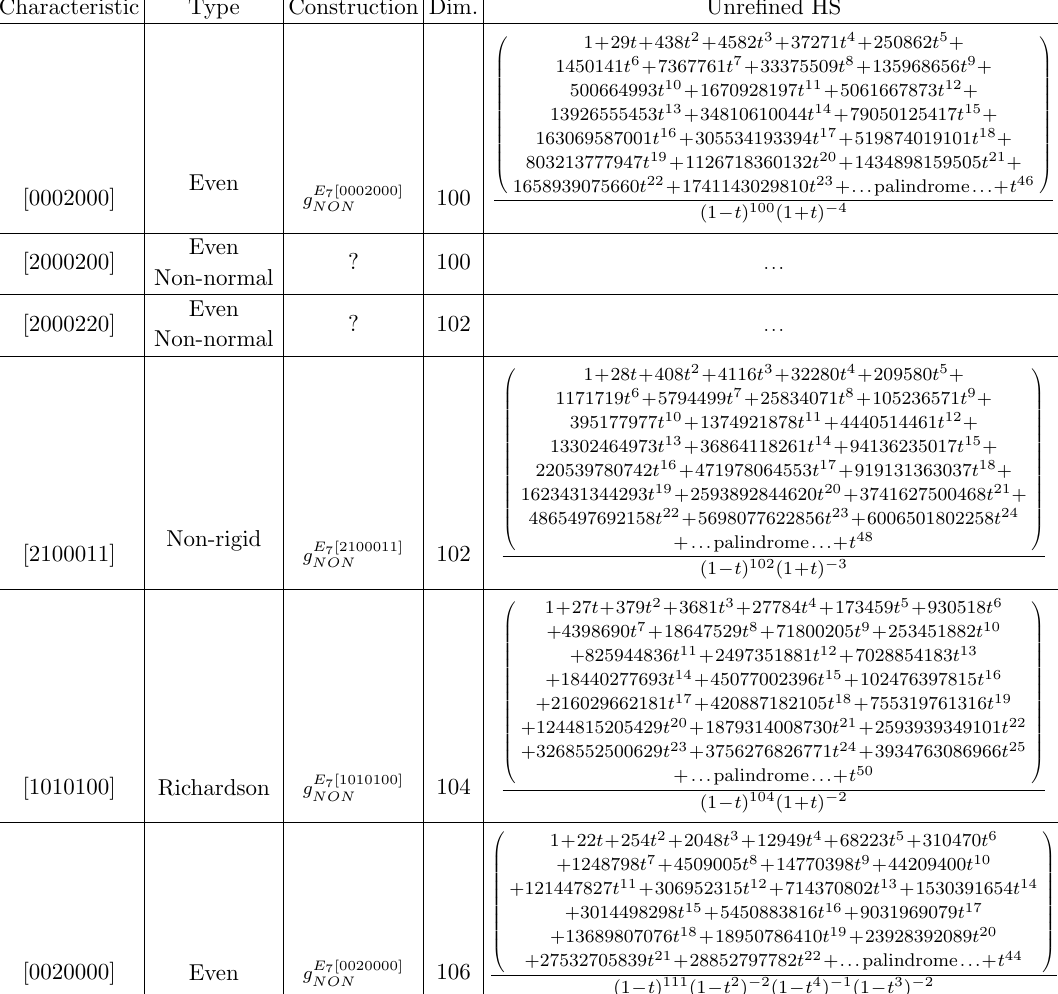
Table 21 . E 7 orbit constructions and Hilbert series